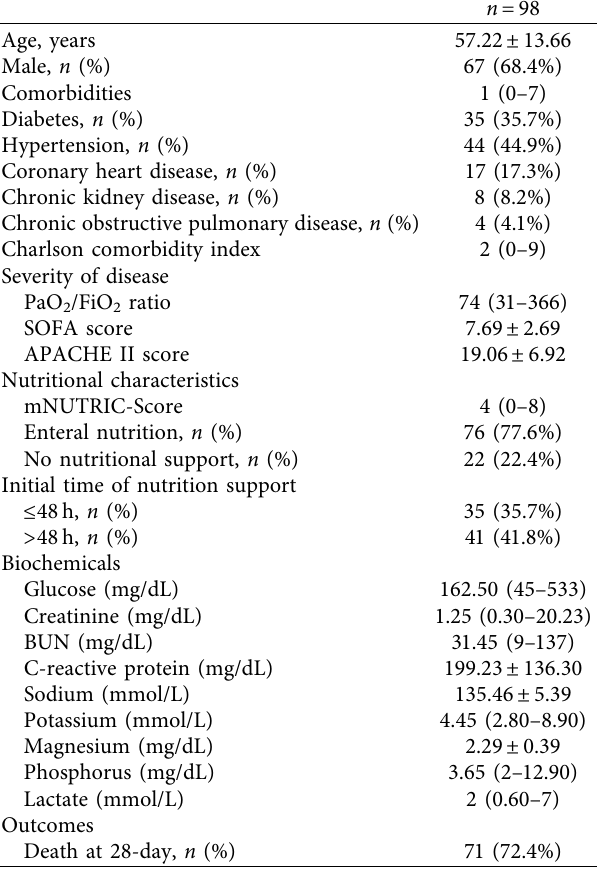
Table 1: Characteristics of mechanically ventilated critically ill COVID-19